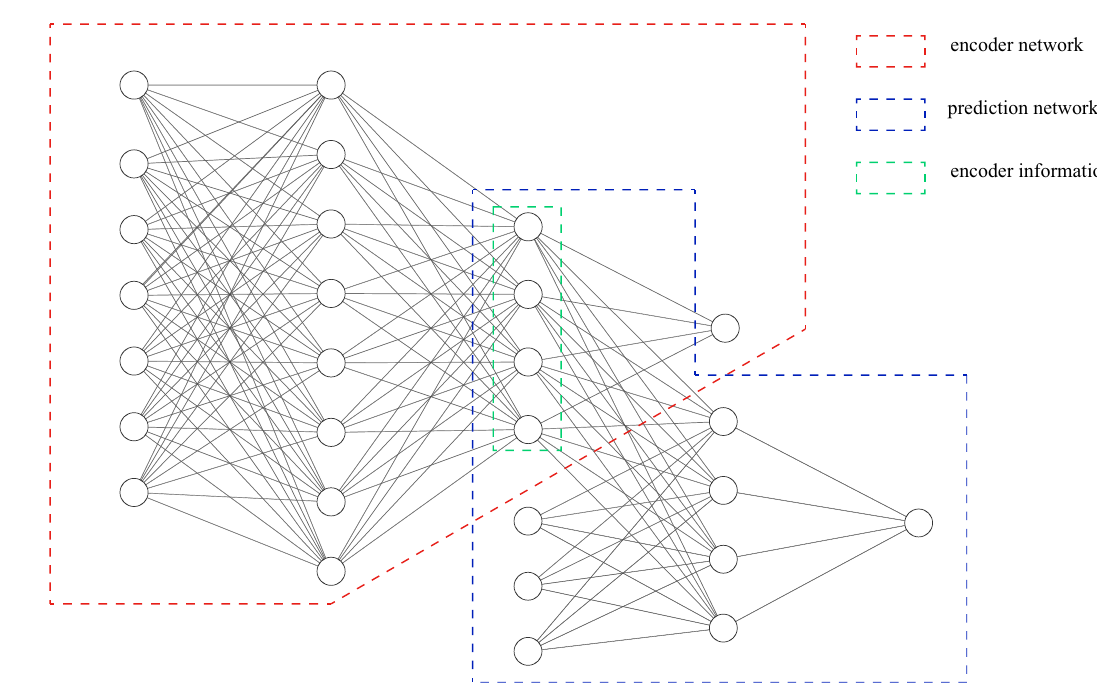
Figure 6. The structure of the proposed neural